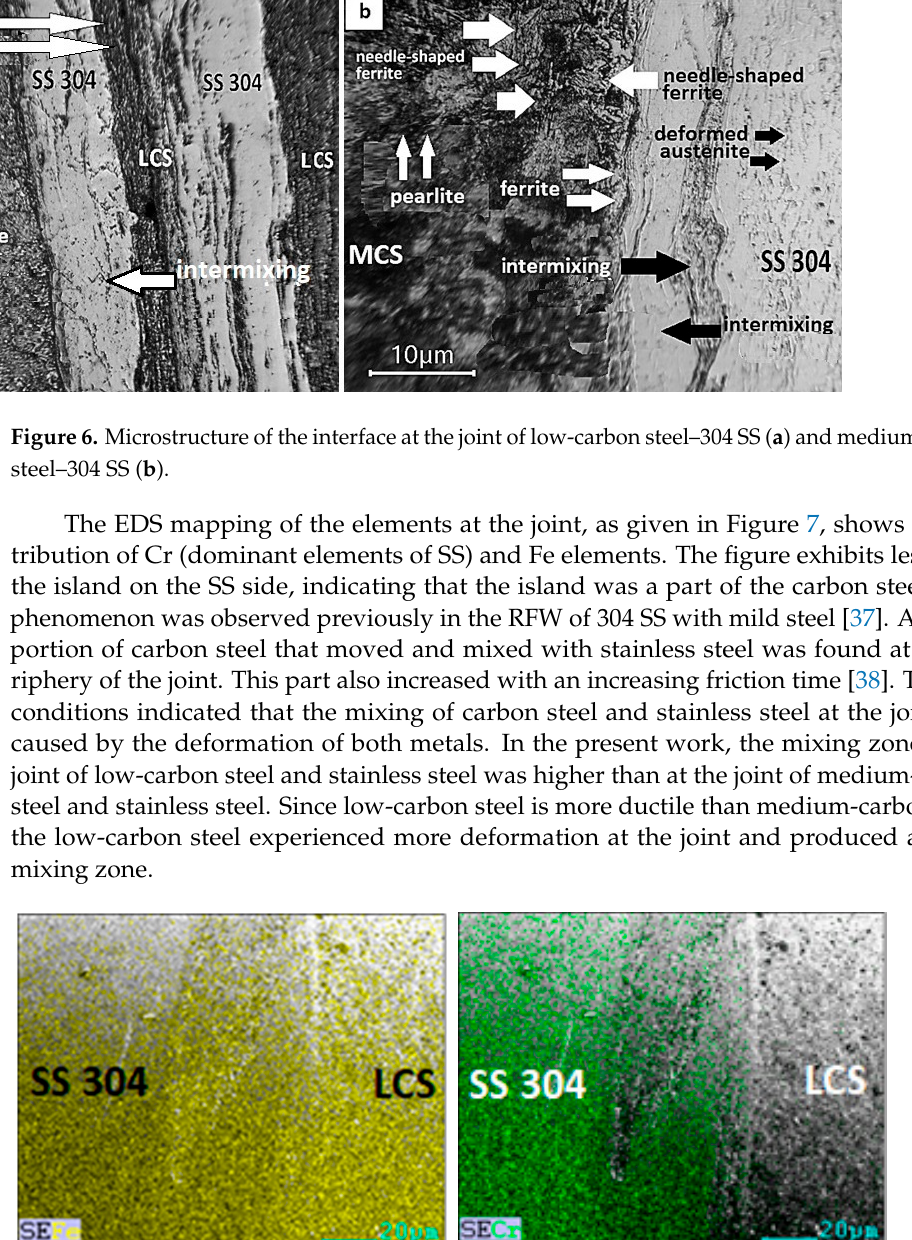
Figure 7. EDS element (Fe and Cr) mapping at the joint of low-carbon steel–304 SS.